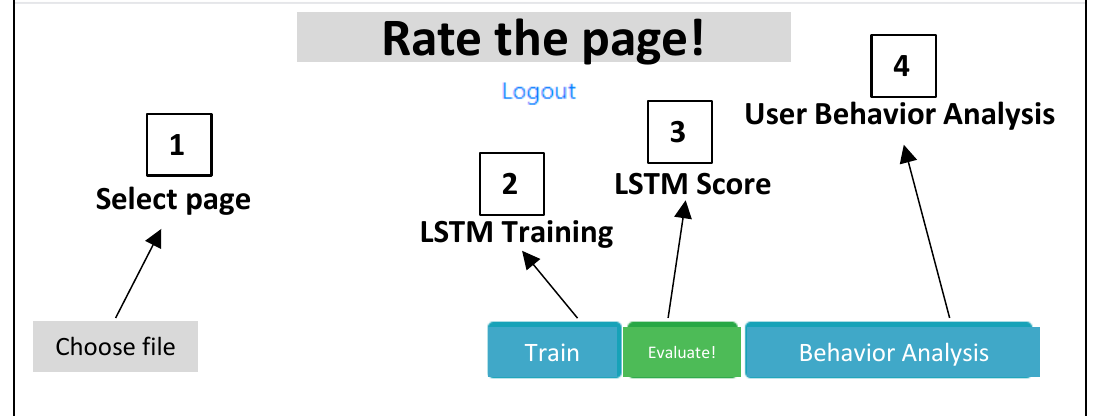
Figure 8. “ANDUIA” platform GUI of the web designer interfa ce.